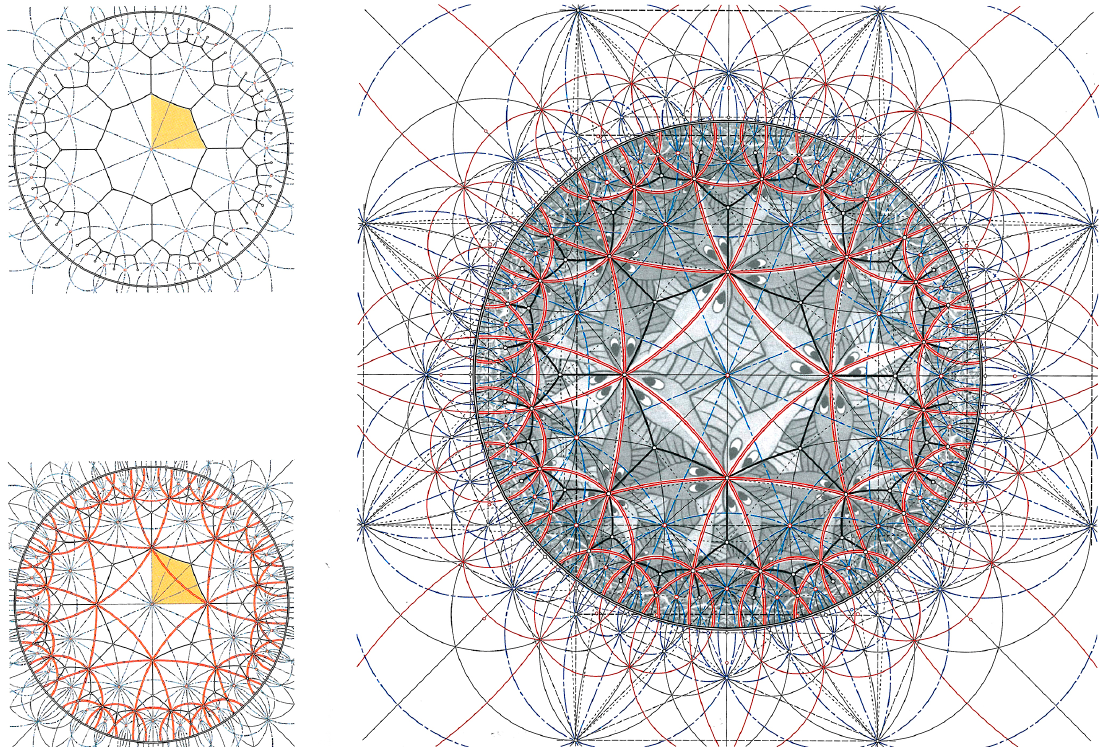
Figure 3. Identification and construction of the hyperbolic structure of Circuit limit III , a work done by Maurits Cornelis Escher in 1959. [7] (pp.